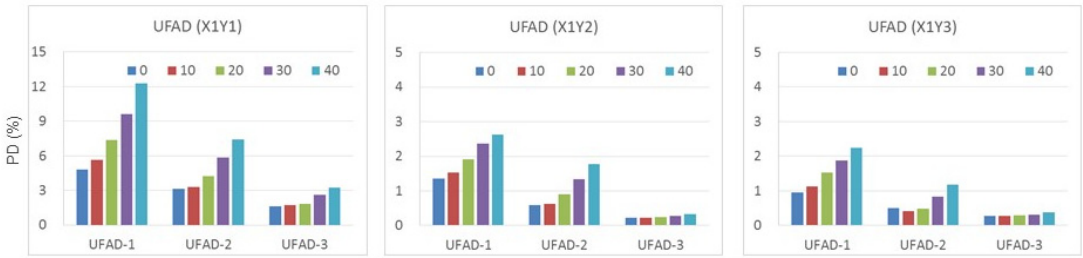
Figure 19. PD by temperature differential 0.1–1.6 m above the floor, CBAD.